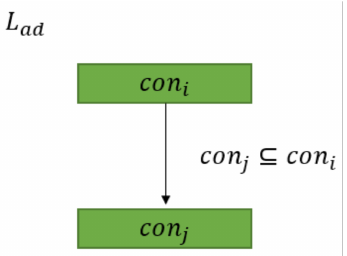
Figure 6. Transmission Relationship of Usage Authority. Whitelisting Approach.